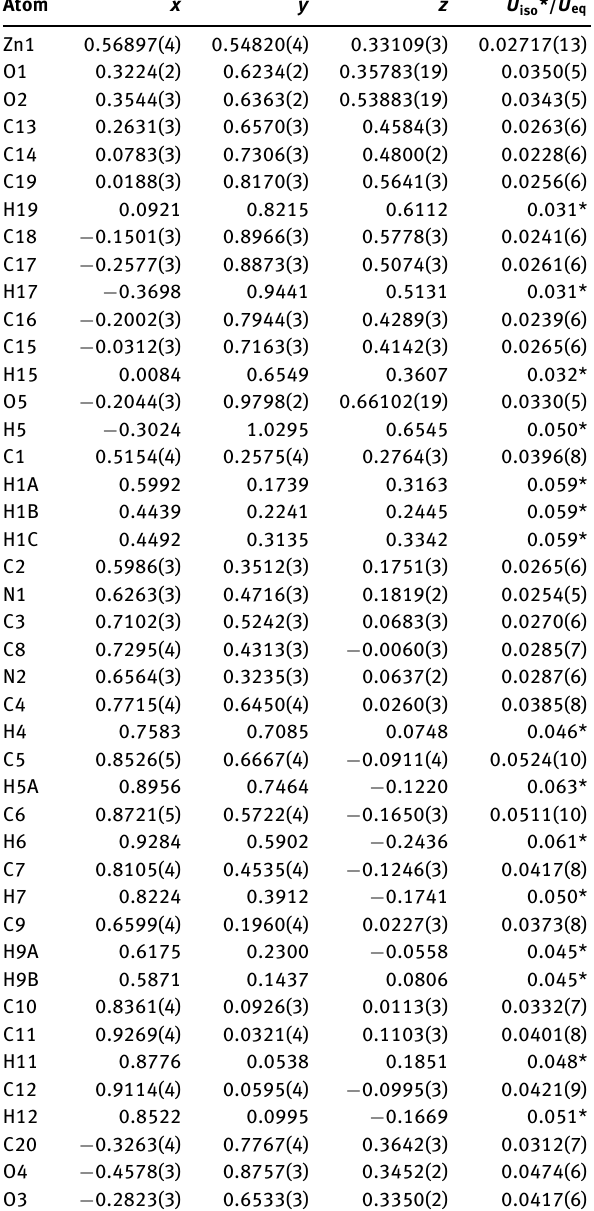
Table 2: Fractional atomic coordinates and isotropic or equivalent isotropic displacement parameters (Å 2